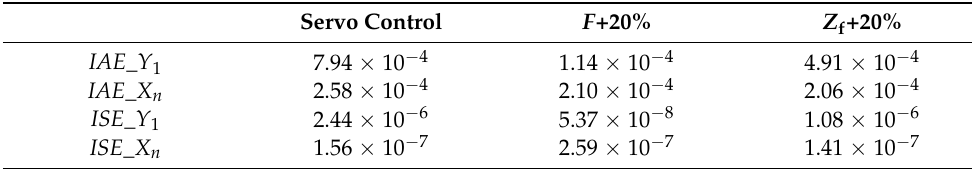
Table 5. Error index of PID in Case